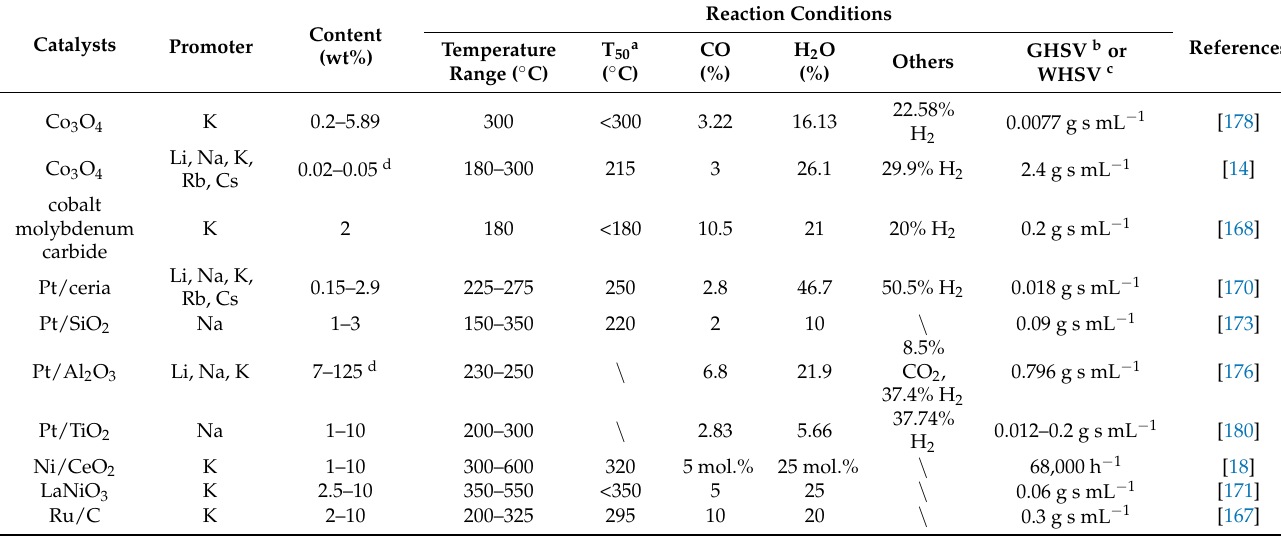
Table 8. Summary of catalysts and reaction conditions for WGS catalysts promoted by alkali